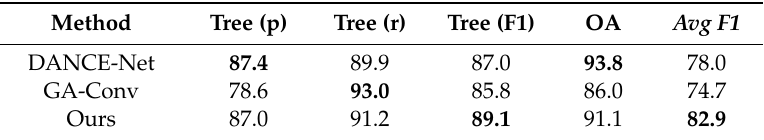
Table 5. Quantitative comparison between our model and other methods on the DFC 3D dataset. We report the precision (p), recall (r), and F1 score for tree category in the first 3 columns as well as the overall accuracy (OA) and average F1 score ( Avg F1 ) in the last two columns. The boldface text indicates the best performance (All values are in